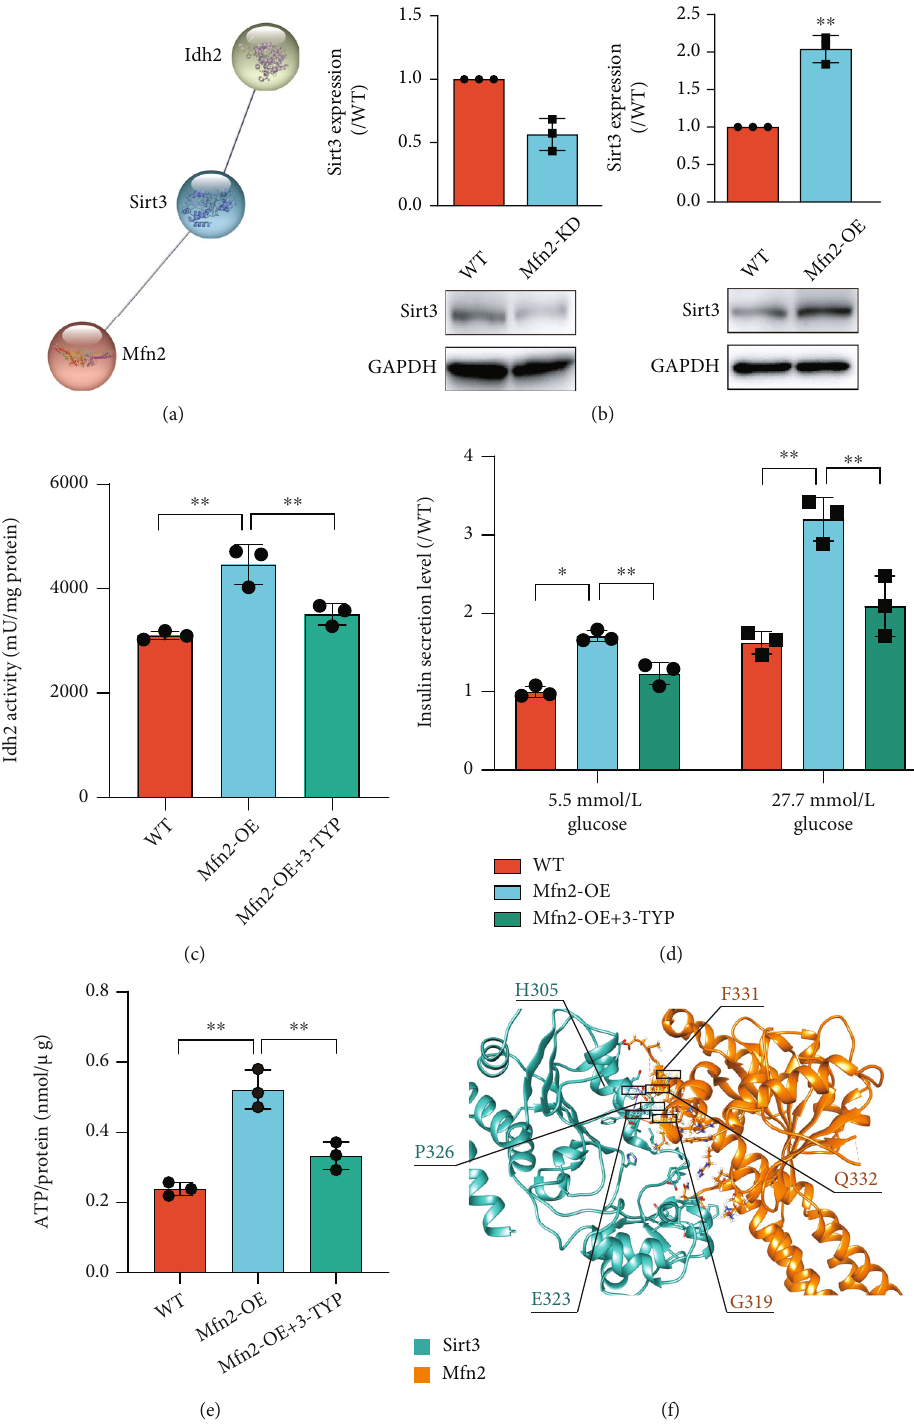
Figure 6: Sirt3 involved in Mfn2 promoted β cell maturation by regulating Idh2. (a) Potential interaction between Mfn2 and Idh2 was predicted by STRING database. (b) Protein expression levels of Sirt3 on day 5 + 28 after Mfn2 knockdown of overexpression. (c) Idh2 activity was detected by Idh activity assay kit at termination day of di ff erentiation after Mfn2 overexpression with or without 3-TYP treatment. (d) Insulin secretion level of β cells was measured at termination day of di ff erentiation after Mfn2 overexpression with or without 3-TYP treatment. The insulin secretion level in each group was normalized to the insulin secretion level of WT cells stimulated with 5.5mmol/L glucose. (e) ATP production on day 5 + 28 after one-hour 2.5 mmol/L glucose stimulation. The ATP levels were compared to the total protein amount. n = 3 . (f) Molecular docking analysis of Mfn2 and Sirt3. The green model represents Sirt3, and the yellow model represents Mfn2. Values represent mean ± S : D . Statistical signi fi cance was set as ∗ P < 0 : 05 and ∗∗ P < 0 : 01 . Student ’ s t -test for (b, c); one-way ANOVA for (e); two-way ANOVA for